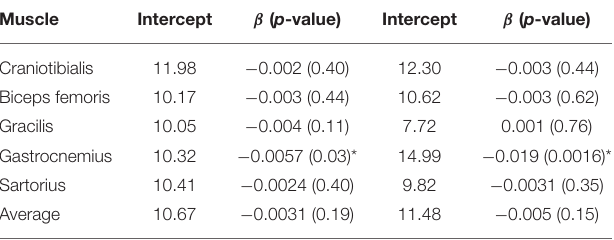
TABLE 2 | Mixed model analysis of longitudinal progression in DM affected dogs.